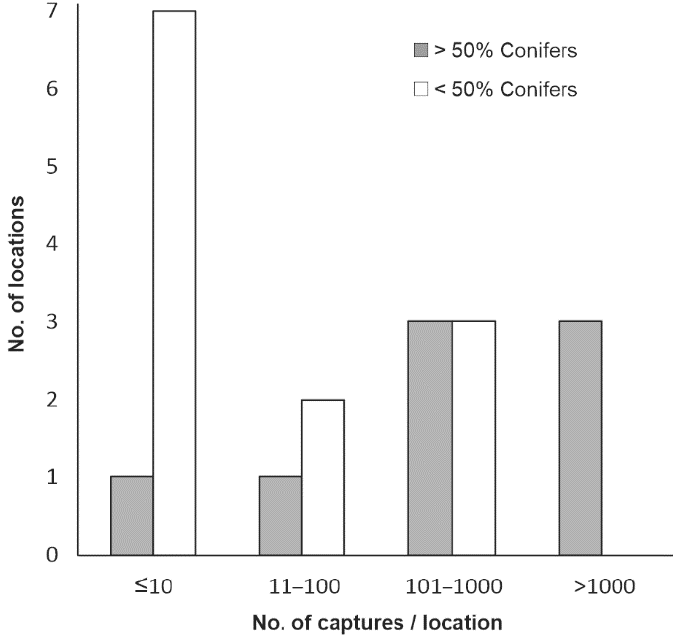
Figure 2. Number of locations and habitats with different NBB capture sizes.